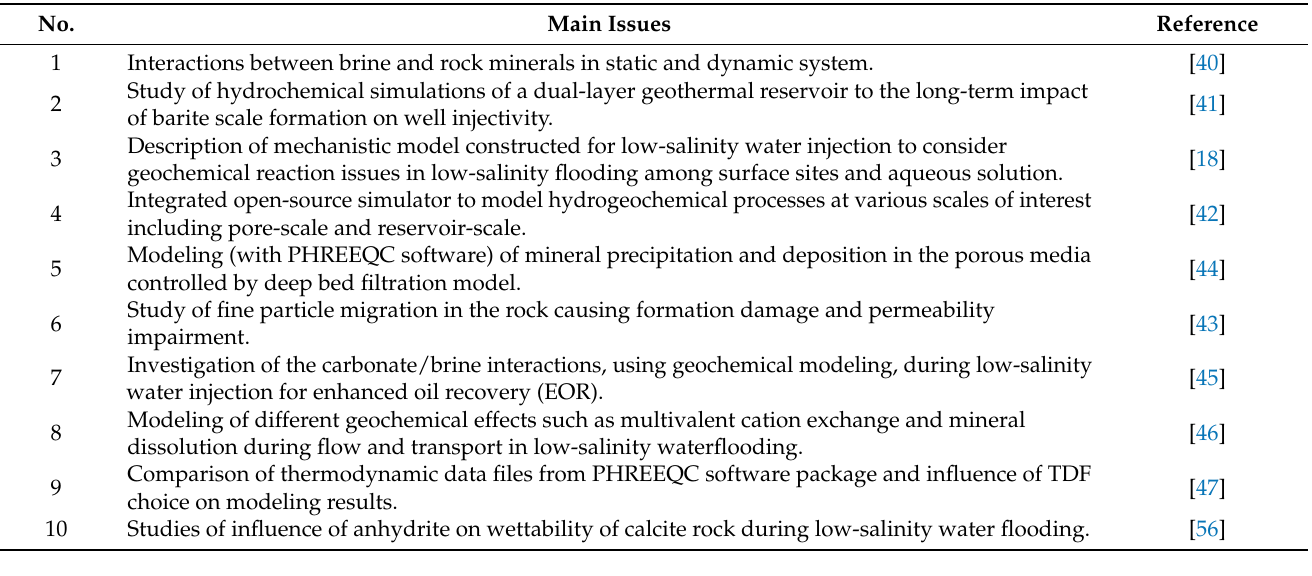
Table 2. Major findings from the literature (last 2 years) concerning phenomena accompanying the injection of water.